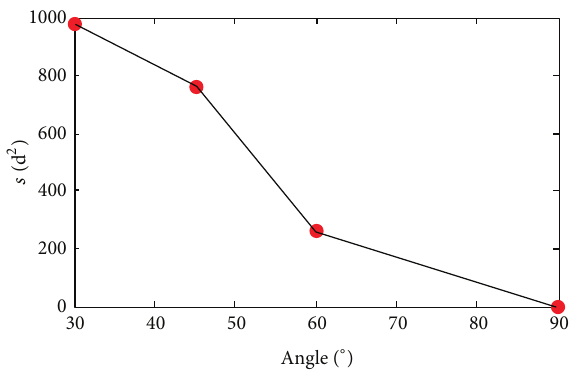
Figure 12: The simulation results about the cone angle and the stagnant zone size ( 𝑓 = 0.2 , ℎ = 160 d).